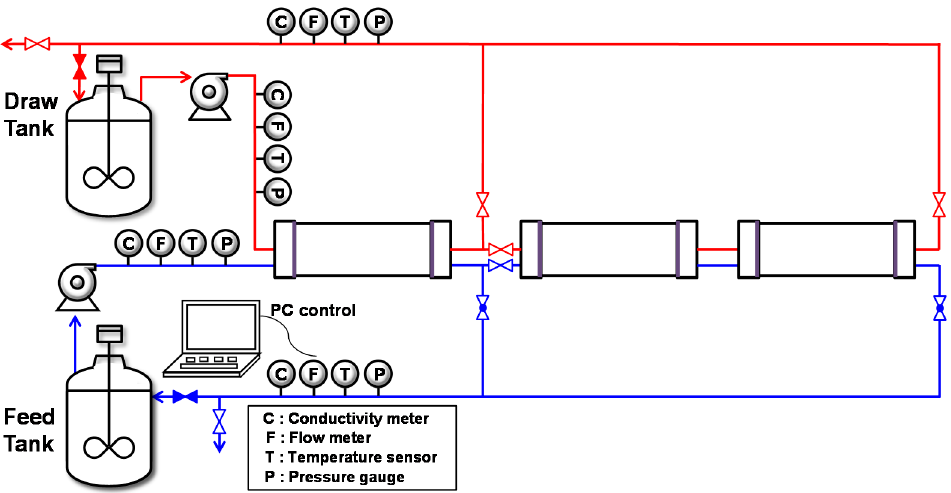
Figure 1. Schematic diagram of forward osmosis (FO) experimental setup with spiral-wound FO elements. The modules can be operated individually or up to three elements can be operated in series.